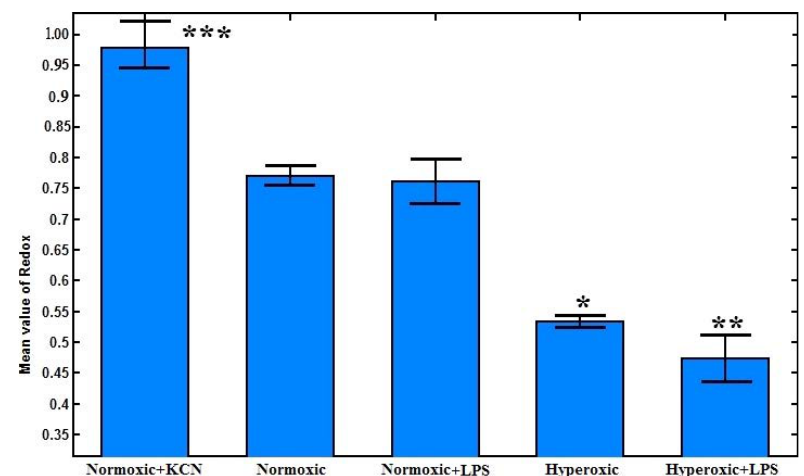
Fig. 4. Bar graph showing the mean and standard errors of the mean value of mitochondrial RR for each of the ¯ve groups of lungs. The number of lungs N ¼ 3, 5, 4, 4 and 4 for normoxic þ KCN , normoxic, normoxic þ LPS , hyperoxic and hyperoxic þ LPS , respectively. The results show a signi¯cant di®erence between normoxic and hyperoxic (* p < 0 : 01), normoxic and hyperoxic þ LPS (** p < 0 : 01), and normoxic and normoxic þ KCN lungs (*** p < 0 :